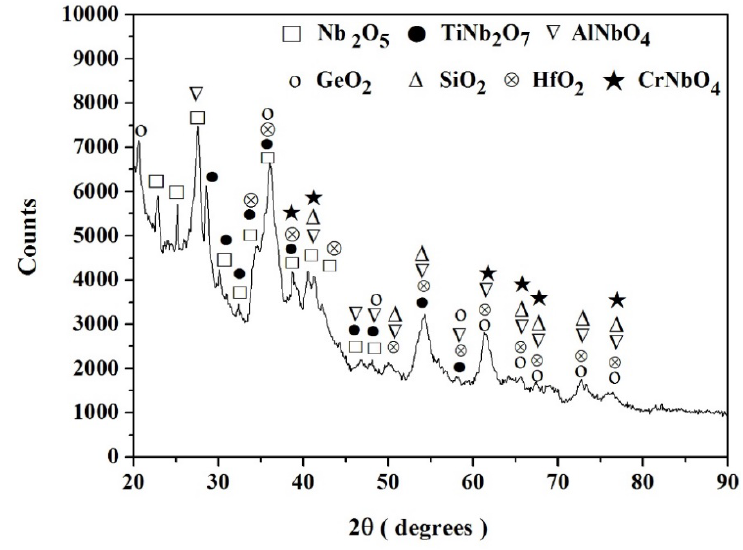
Figure 9. GXRD data ( γ = 1 ◦ ) for the scale formed on the alloy ZF9 after oxidation in air at 800 ◦ C for 100 h.